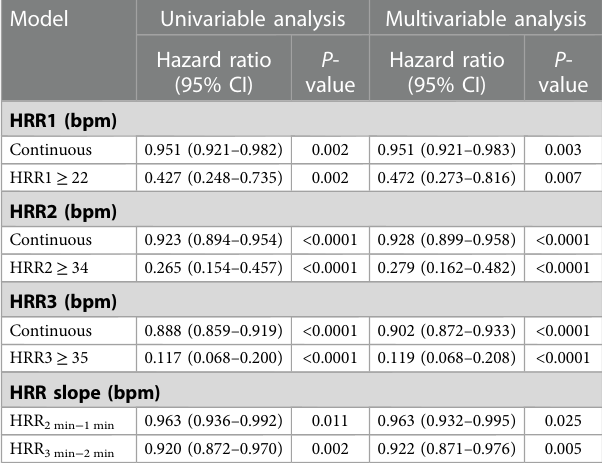
dichotomous variable. Therefore, continuous HRR3 was included in the model to assess its incremental value.